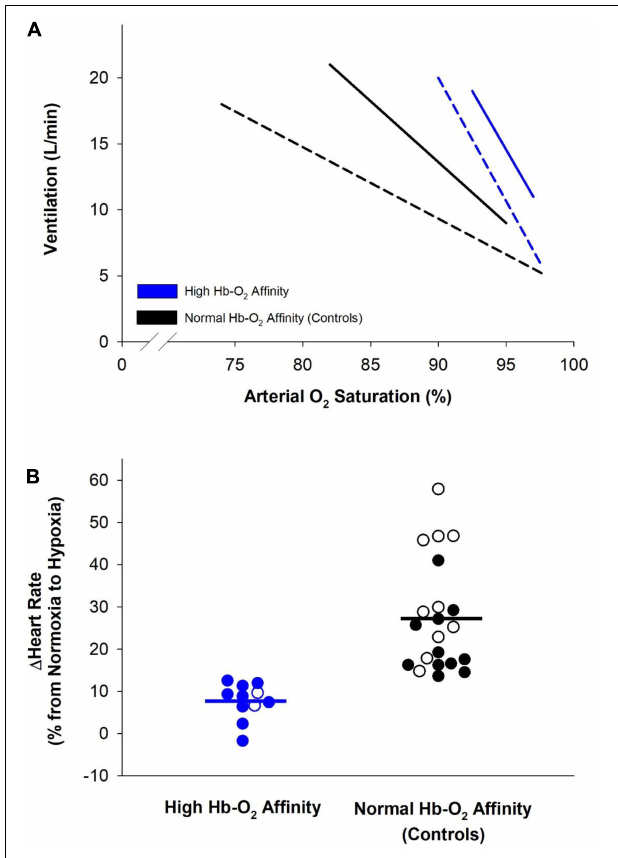
FIGURE 2 | Cardiorespiratory adjustments elicited during hypoxia by humans with high hemoglobin-O 2 (Hb-O 2 ) affinity (blue lines and symbols) and controls with normal Hb-O 2 affinity (black lines and symbols). (A) Relationship of minute ventilation and arterial O 2 saturation among humans with high Hb-O 2 affinity compared to normal Hb-O 2 affinity controls during progressive isocapnic hypoxia. Dashed lines represent data from Hebbel et al. (1977) where hypoxia was increased such that alveolar P O was lowered from 120 to 2 40 mmHg over ∼ 5 min ( n = 2 humans with high Hb-O 2 affinity and n = 2 humans with normal Hb-O 2 affinity). Solid lines represent data from Dominelli et al. (2019) where hypoxia was increased such that end-tidal P O was 2 lowered from normal room-air values to 50 mmHg over ∼ 12 min ( n = 9 humans with high Hb-O 2 affinity and n = 12 humans with normal Hb-O 2 affinity). (B) Percentage increase in heart rate during progression of normoxia to hypoxia among humans with high Hb-O 2 affinity compared to normal Hb-O 2 affinity controls. Open symbols represent data from Hebbel et al. (1977) where heart rate was compared at an alveolar P O of 100 and 2 40 mmHg ( n = 2 humans with high Hb-O 2 affinity and n = 10 humans with normal Hb-O 2 affinity). Filled symbols represent data from Dominelli et al. (2019) where heart rate was compared at normoxia and at an end-tidal P O of 2 50 mmHg ( n = 9 humans with high Hb-O 2 affinity and n = 12 humans with normal Hb-O 2 affinity). Solid bars represent the average change in heart rate in both